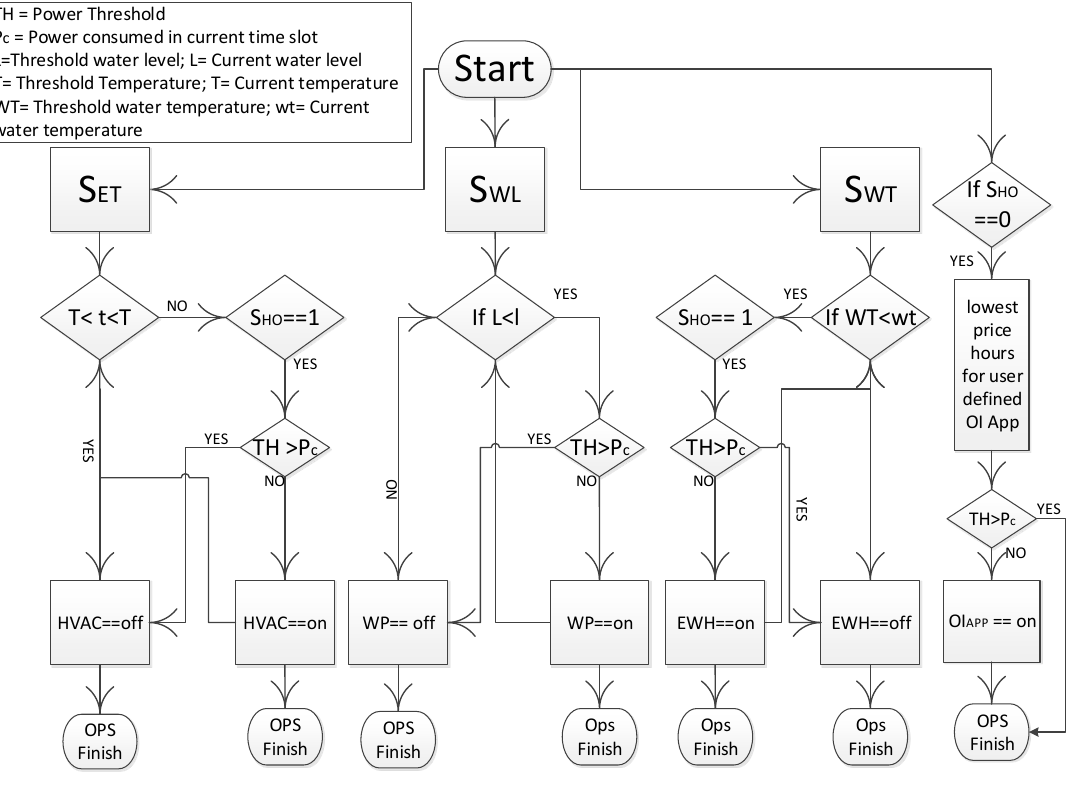
Figure 2. Flow chart: EMS (Scenario